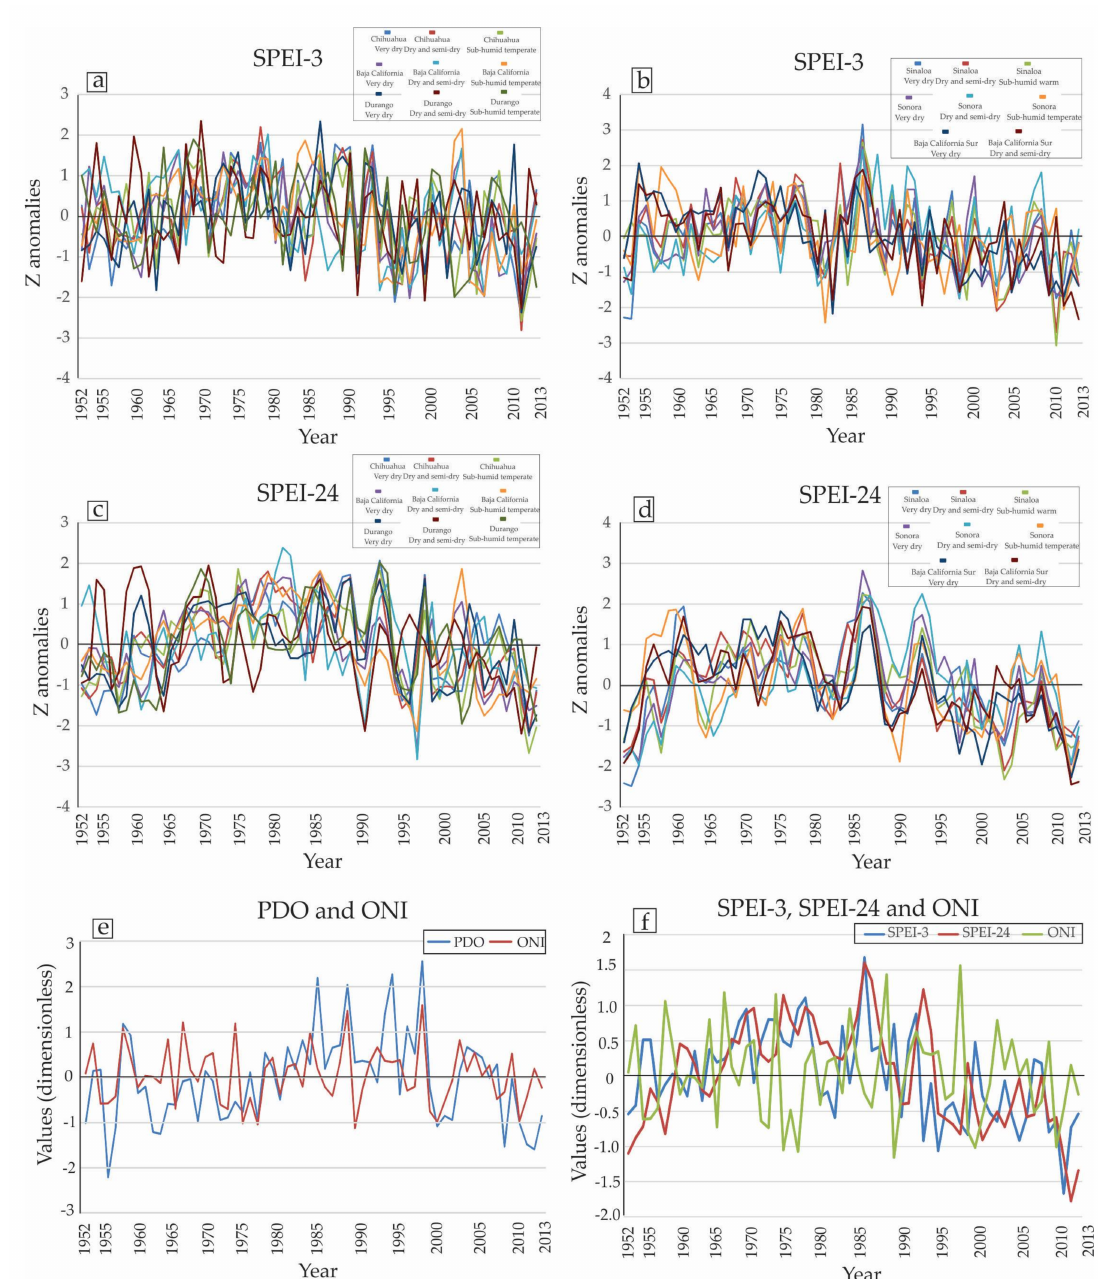
Figure 6. ( a , b ) Standardized Z anomalies of SPEI-3 (dimensionless); ( c , d ) standardized Z anomalies of SPEI-24 (dimensionless); ( e ) values of pacific decadal oscillation (PDO) and oceanic El Niño index (ONI) (dimensionless); and ( f ) average annual variability of SPEI-3, SPEI-24 and ONI